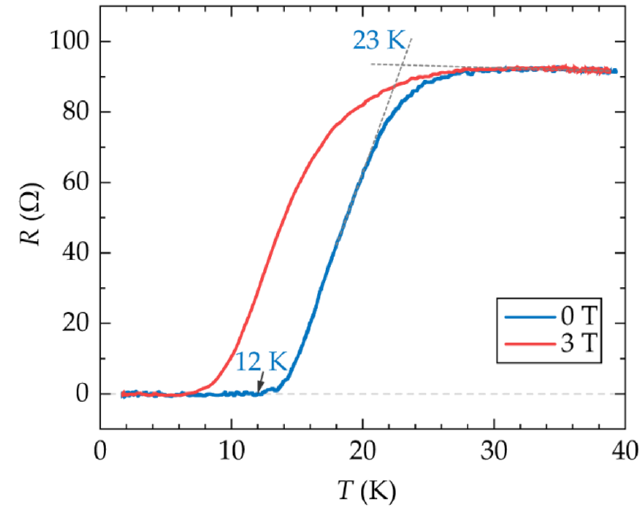
Figure 4. Resistance-temperature curves of a 1.5-layer FeSe film grown with Se(180,1000) in the magnetic field of 0 T and 3 T (B//c). The film is capped with 10 layer